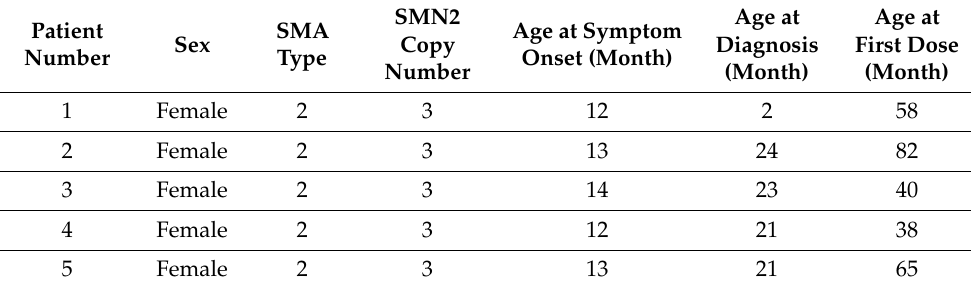
Table 1. Baseline characteristics of the study